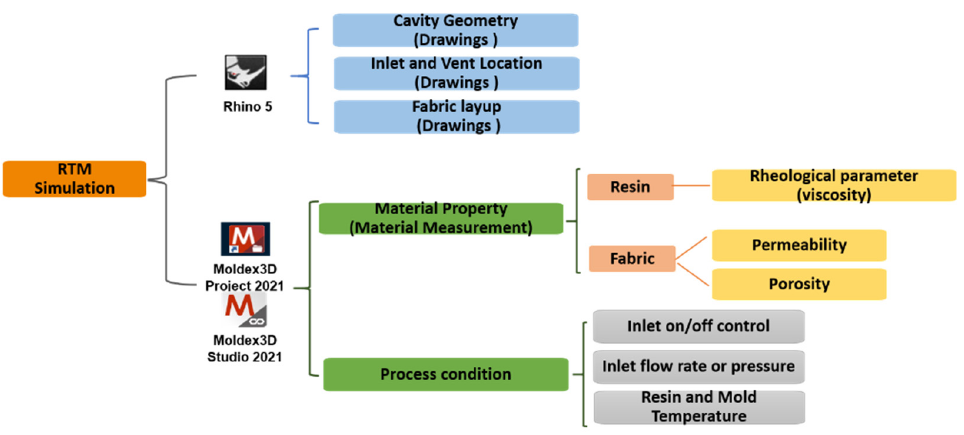
Figure 8. Parameters used in numerical simulations.